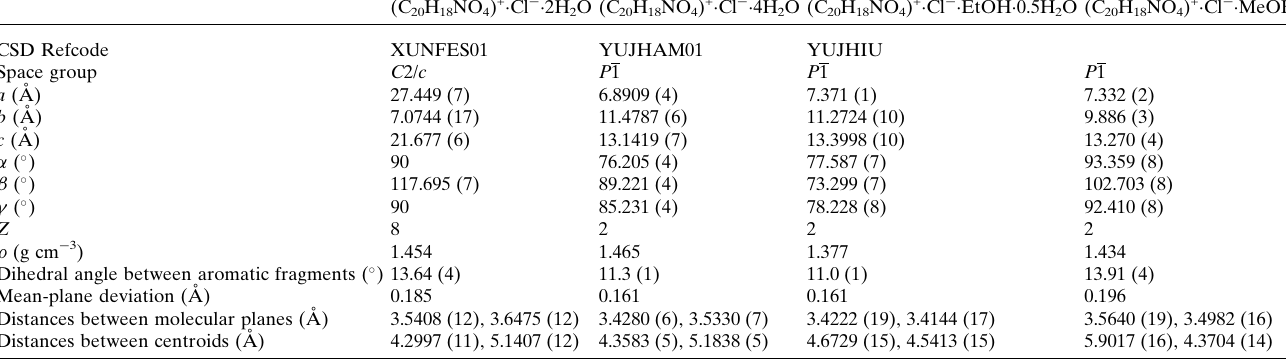
Table 1 Selected crystallographic data for berberine chloride